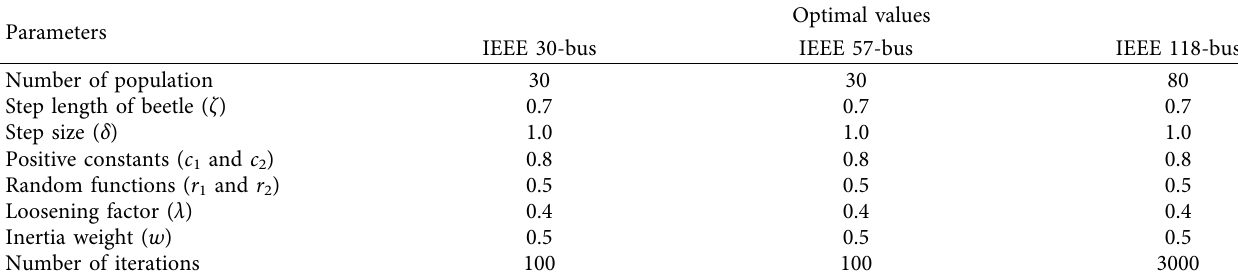
Table 3: Optimal control-parameters values of proposed BSOA.